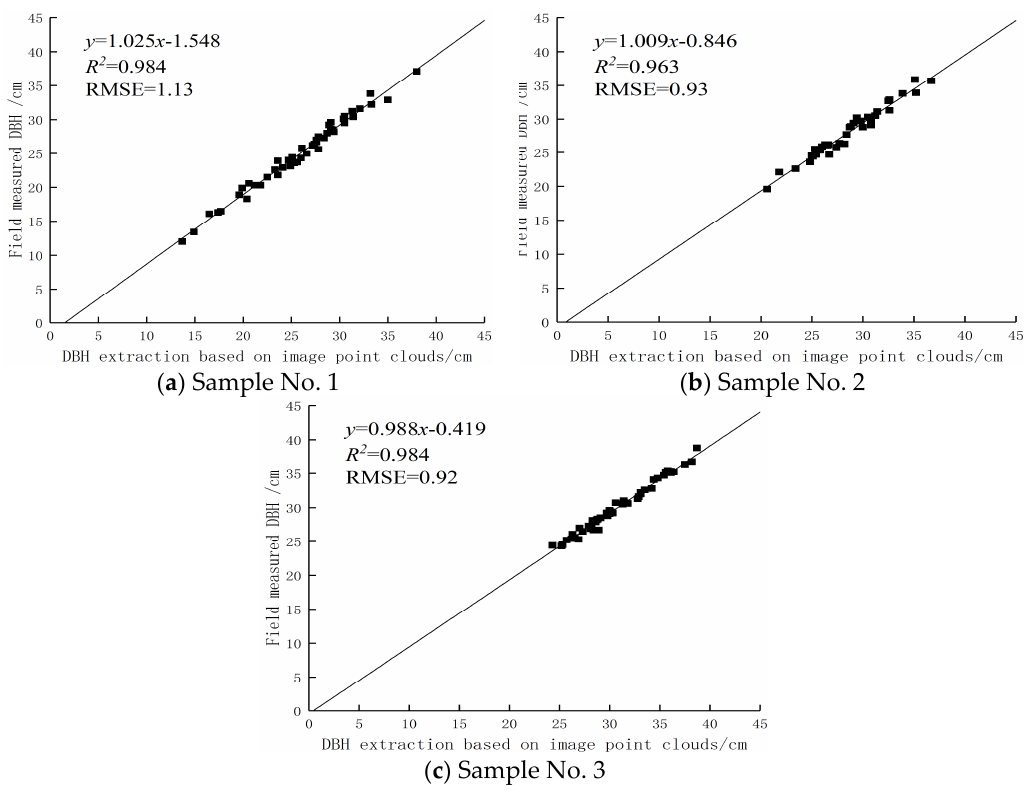
Figure 12. Comparative analysis of the DBH extraction values based on the image point clouds and the field measured value. ( a ), ( b ), and ( c ) are the comparative analysis of the DBH of plots 1, 2, and 3, respectively.